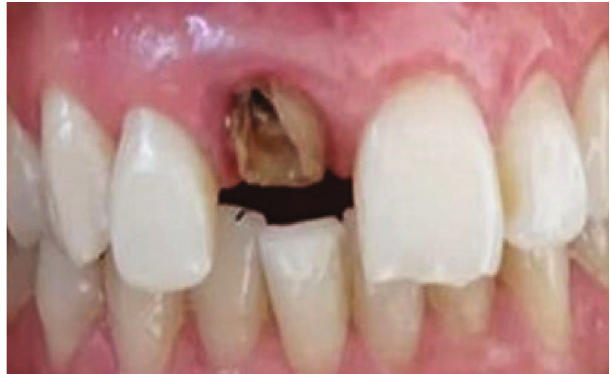
Figure 5: After the crown removal: dental tissue loss was subtotal and margins were